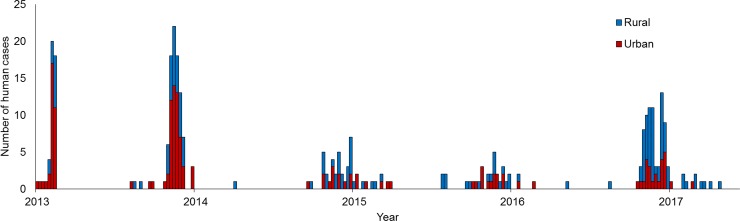
Temporal distribution of urban (red) and rural (blue) H7N9 infections in the five epidemic saves from April 2013 to June 2017 in the Zhejiang province, China.